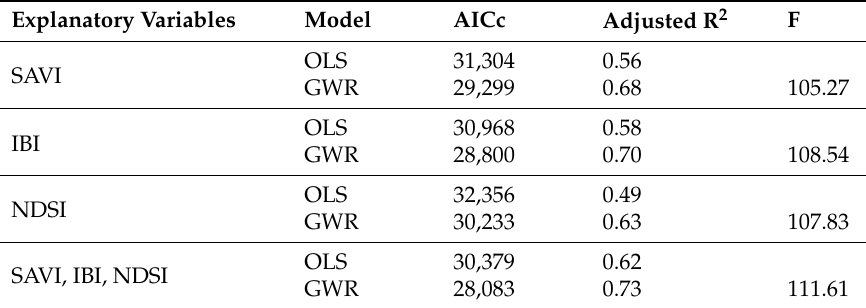
Table 2. The performance comparisons of the OLS and GWR